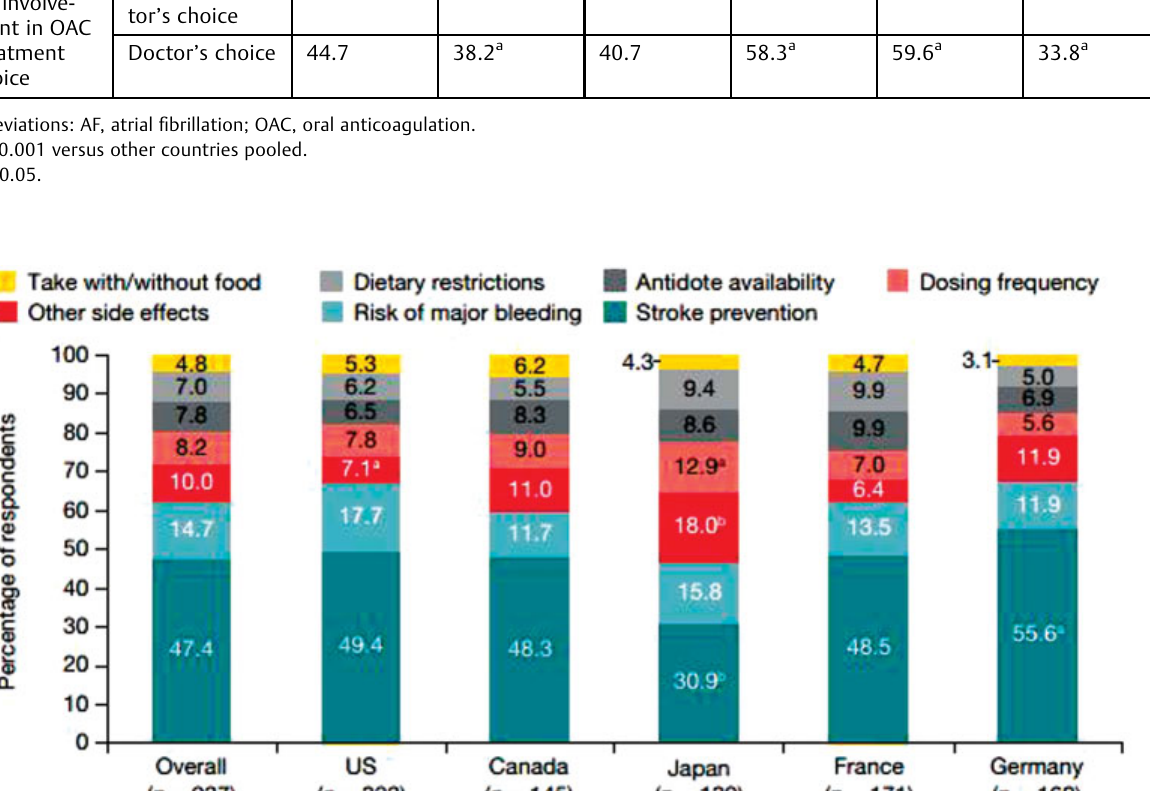
TH Open Vol. 2 No.